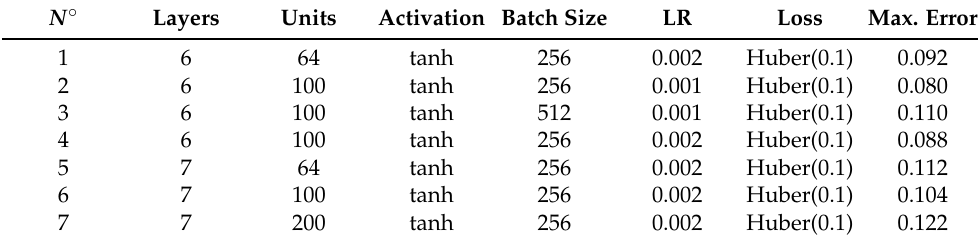
Table 4. Results of different models for maximum heights with the sigmoid activation function in the output layer.